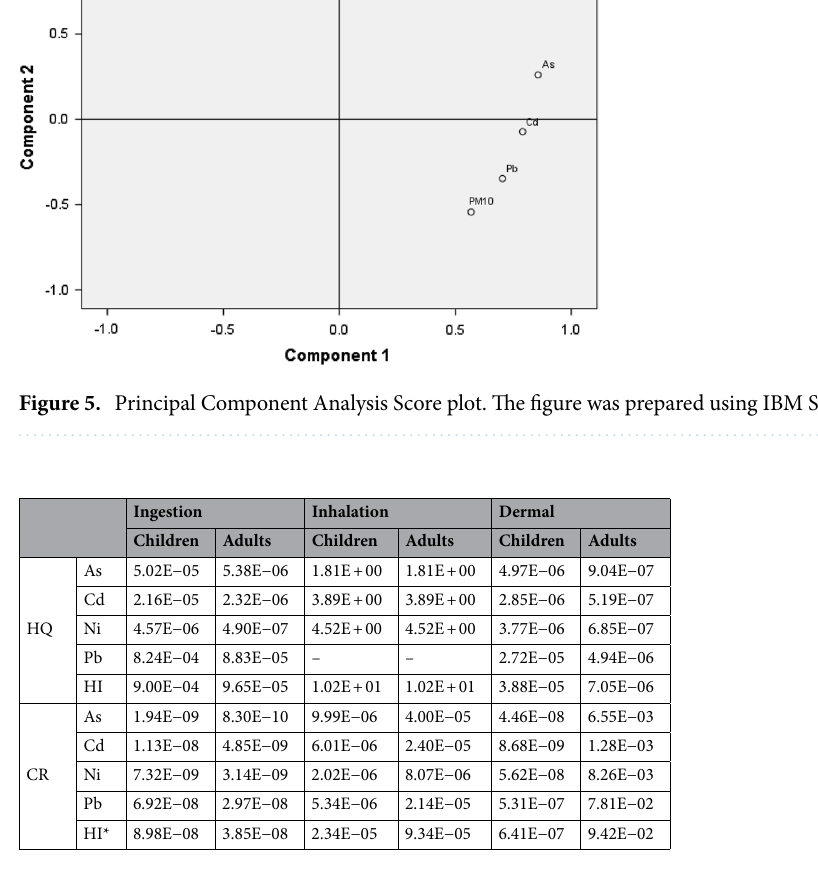
Table 4. Hazard Quotient (HQ) and Cancer risk (CR) from trace elements in PM 10 via ingestion, inhalation, and dermal contact for children and adults. HI *—Hazard